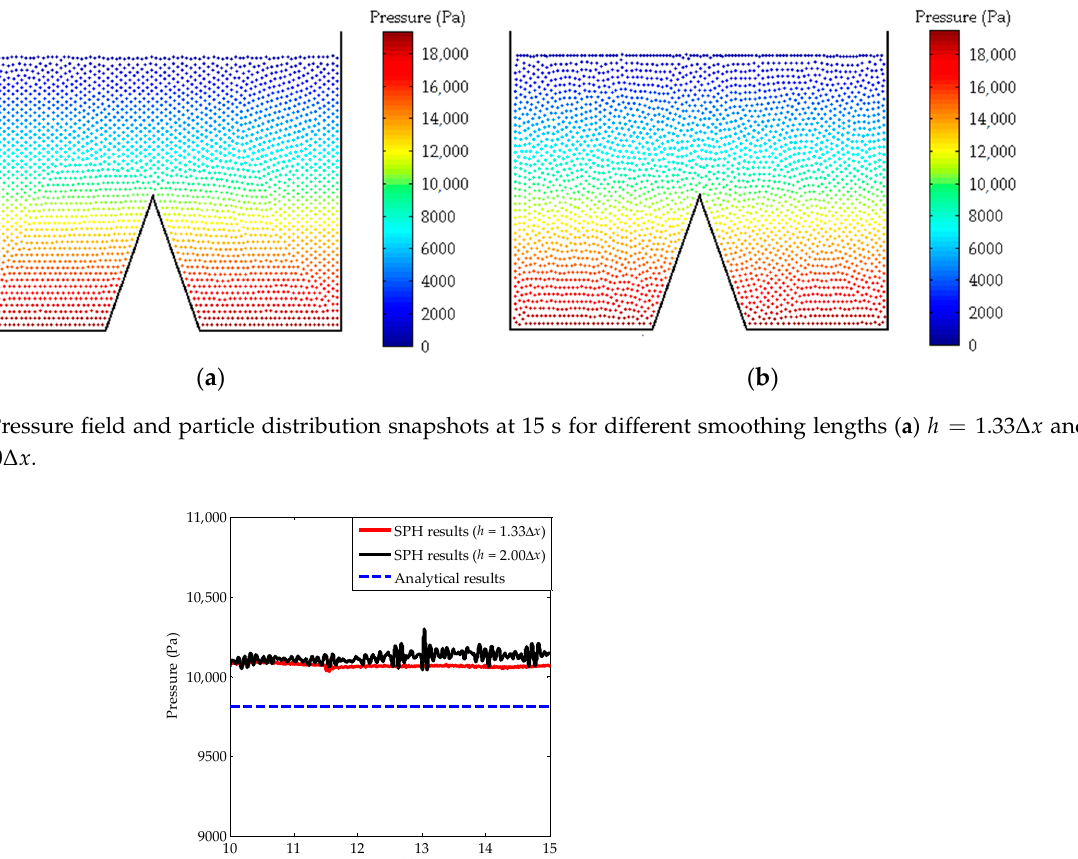
Figure 5. Configuration of the water tank.